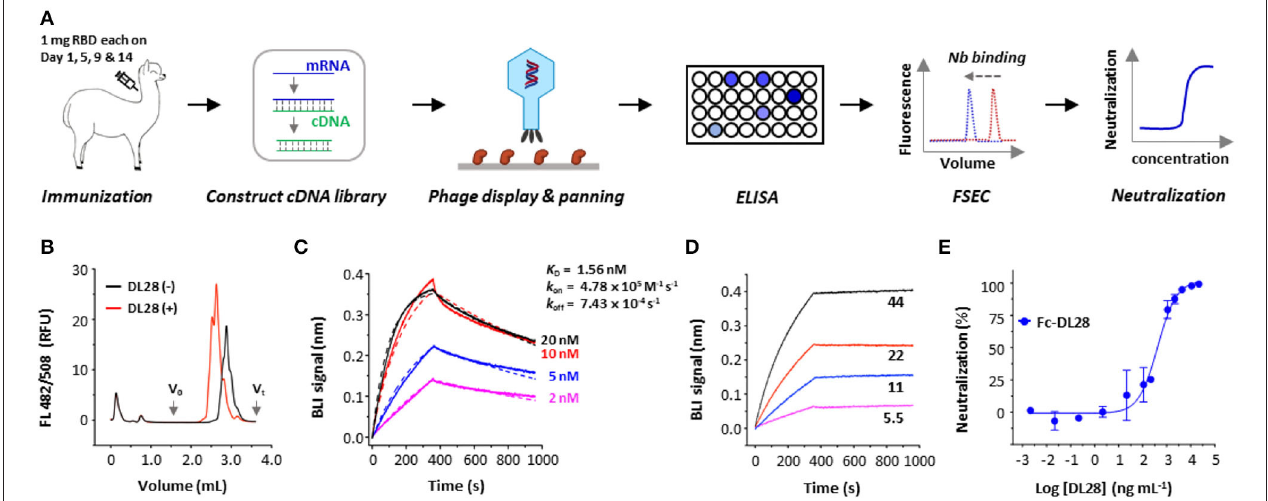
FIGURE 1 | Strategy and isolation of neutralizing nanobodies. (A) Schematic flowchart for the identification of neutralizing nanobodies (Nbs). Immunization dose and schedule are indicated. The mRNA was isolated from an alpaca that was immunized with the RBD. A phage display library expressing nanobodies was selected against RBD. Positive clones were screened using ELISA and fluorescence-detector size exclusion chromatography (FSEC) for RBD-binding, and purified nanobodies were screened using neutralization assays with SARS-CoV-2 pseudoviruses. (B) Unpurified DL28 causes earlier elution of the fluorescently labeled RBD on analytic gel filtration. (C) Binding kinetics of DL28 to RBD using BLI with RBD immobilized and DL28 as analyte at indicated concentrations (nM). Solid lines indicate original data and dotted lines indicate fitted curves. (D) Evidence for the binding between DL28 and S protein. Apparent binding kinetics are not fitted due to the existence of bridged complexes between immobilized DL28 and the trimeric analyte S. (E) Neutralization assay of Fc-DL28 against SARS-CoV-2 pseudoviruses.